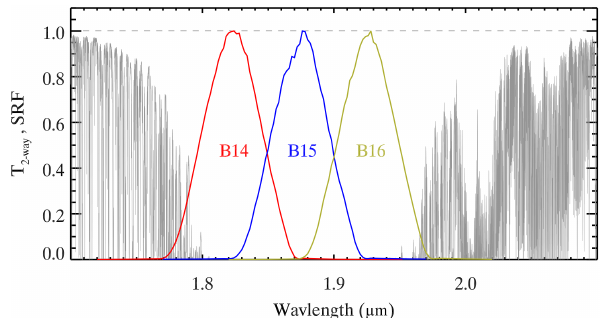
Figure 1. Spectral two-way transmittance (gray line), from TOA to surface, calculated with LBLRTM using a tropical ocean atmo- sphere. Spectral response functions during the SEAC4RS campaign for eMAS bands 14, 15, and 16 (band centers at approximately 1.83, 1.88, and 1.93µm, respectively) are also shown (red, blue, and gold lines, respectively).